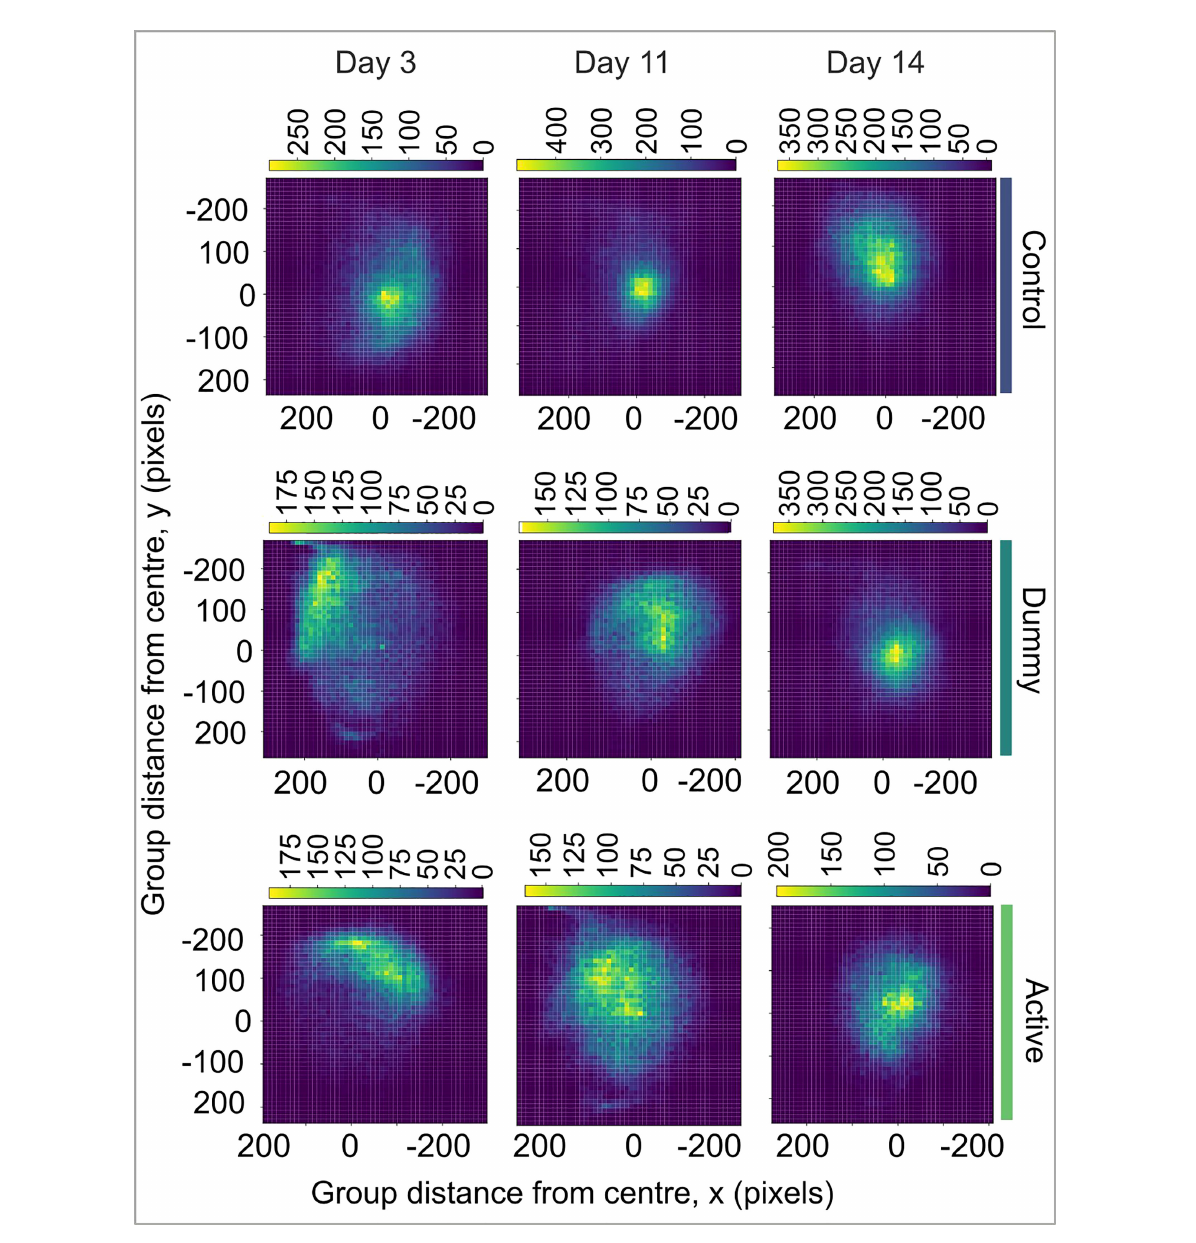
FIGURE 6 Heatmaps showing the distance of the group center from the center of the tank for the control group (top row, light green, N=25), the dummy group (middle row, dark green, N=20), and the active group (bottom row, N=24) for the 3rd, the 11th, and the 14th day of the experiment. The intensity of the color indicates higher number of